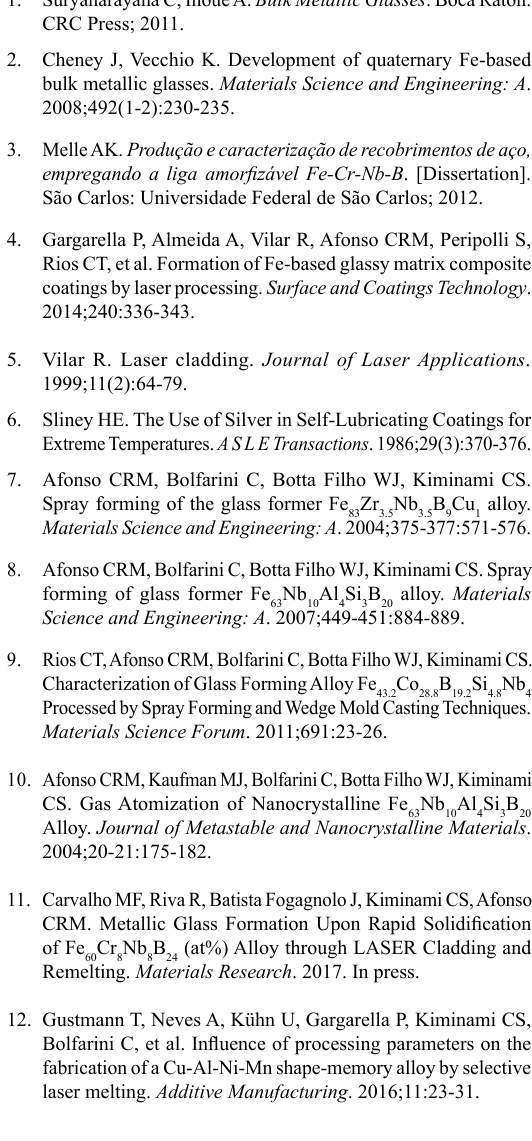
single tracks obtained using 2